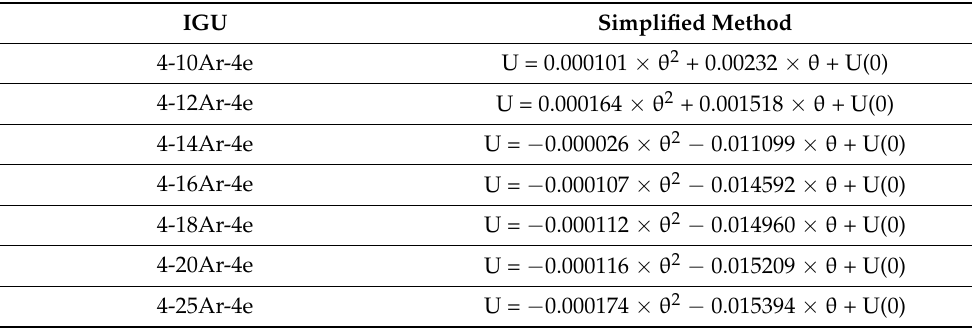
Table 4. Simplified method for recalculation of declared thermal transmittance values U(0) at 0 ◦ C to values at lower external temperatures θ e , ◦ C (double-glazed